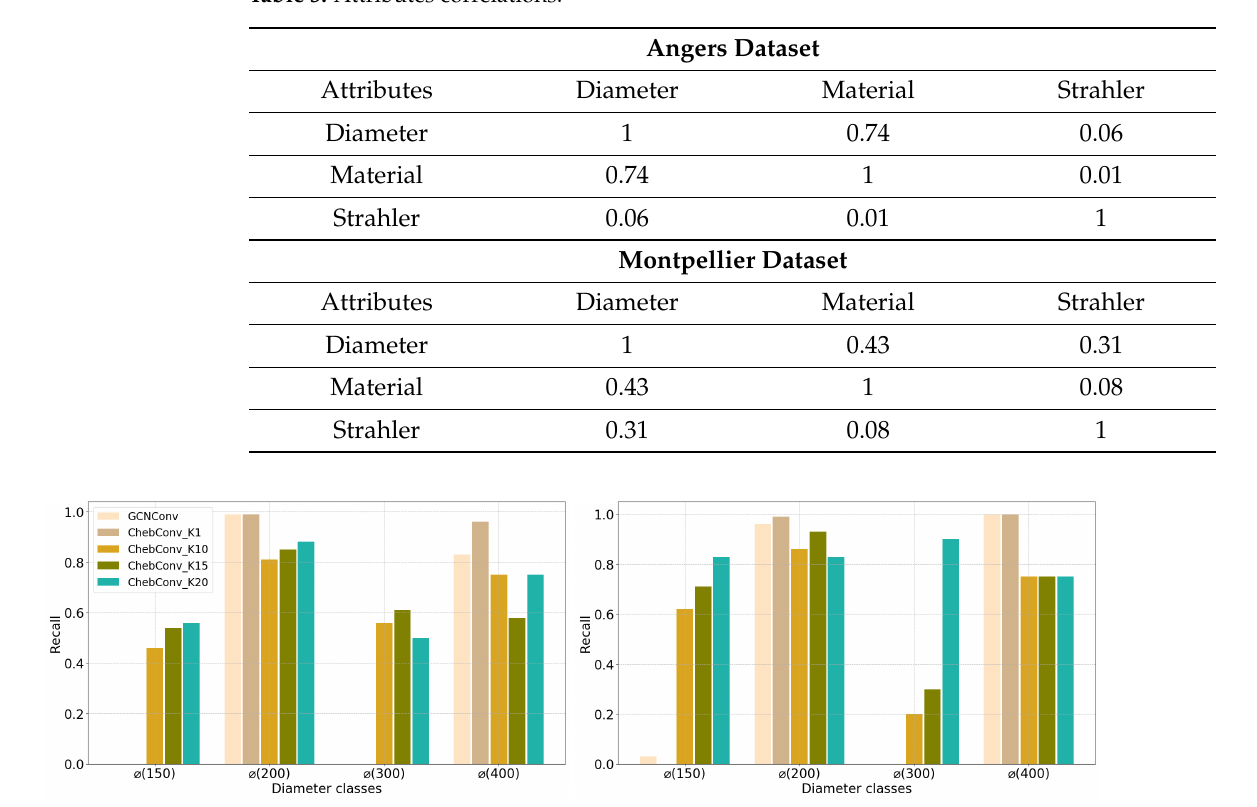
Figure 10. Comparing the GCNConv model with the ChebConv model on the Montpellier